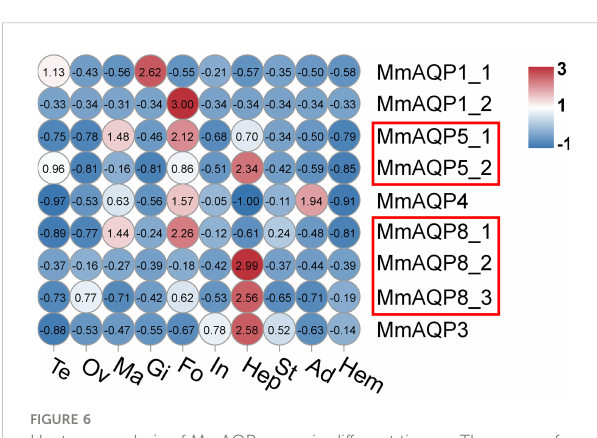
FIGURE 6 Heatmap analysis of MmAQP genes in different tissues. The name of each tissue is abbreviated as follows: Te, testis; Ov, ovary; Ma, mantle; Gi, gill; Fo, foot; In, intestine; Hep, hepatopancreas; St, stomach; Ad, adductor muscle; and Hem, hemolymph. Red indicates a high level of gene expression, and blue indicates low expression. The tandemly- duplicated genes are marked with red